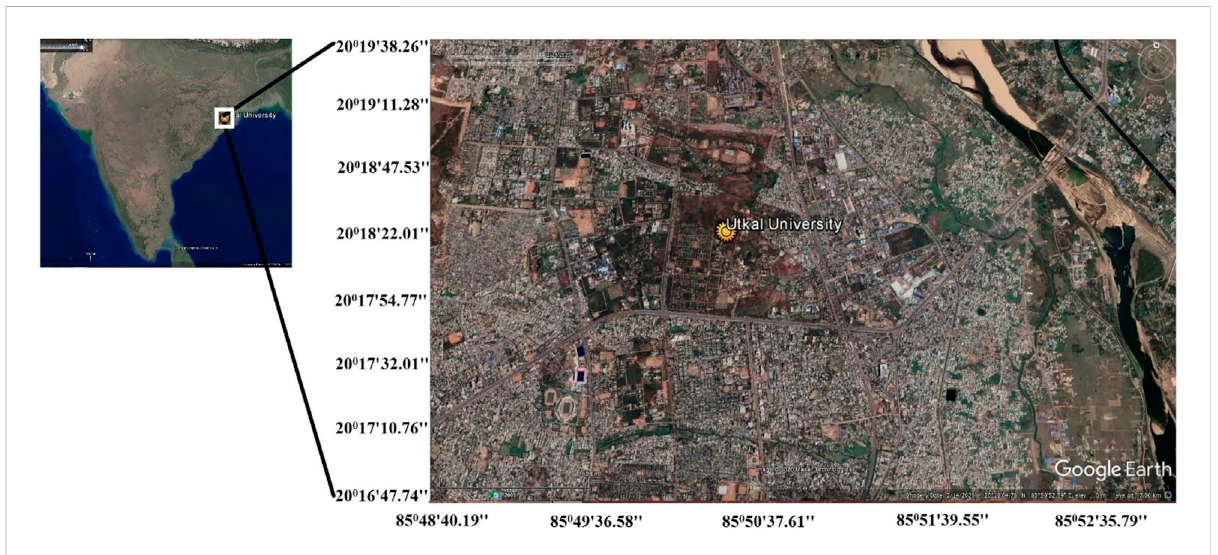
FIGURE 1 Site mapof theobservational site, with itslocation onthemap ofIndiain theinset.The observational siteisrepresented byayellow circle inthe map, obtained from Google Earth